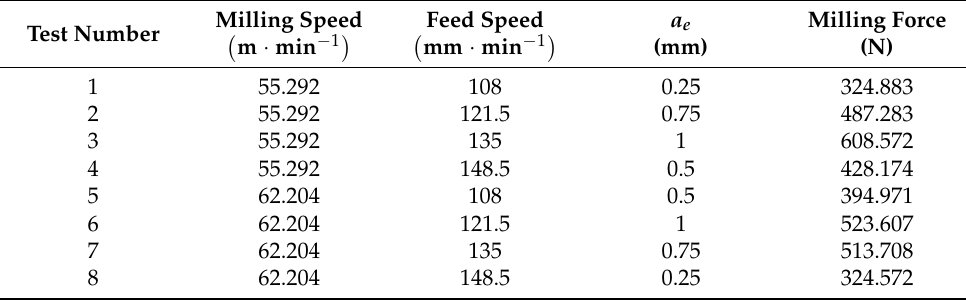
Table 6. Orthogonal test design and test results of side milling of AM block